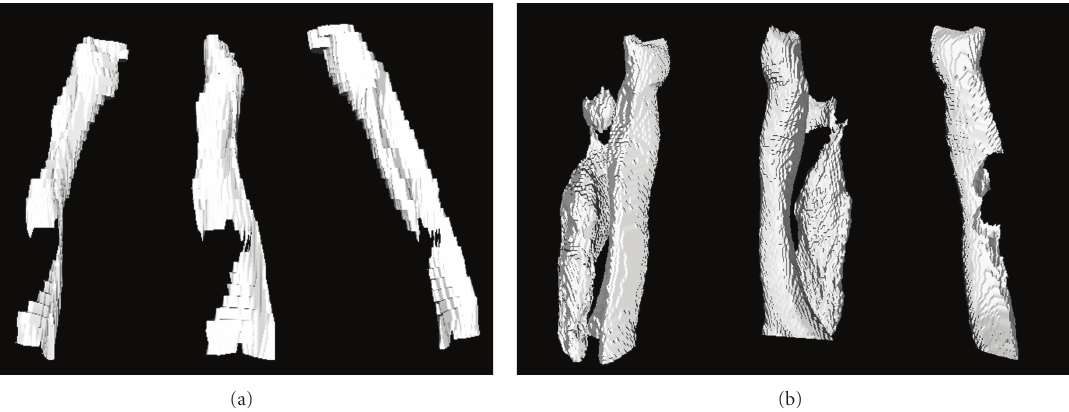
Figure 4: (a) A real, very severe case of stenosis segmented with simple region growing. (b) The trachea and the oesophagus appearing together in the image, after segmentation, followed by the phantom stenosis created on the same trachea.